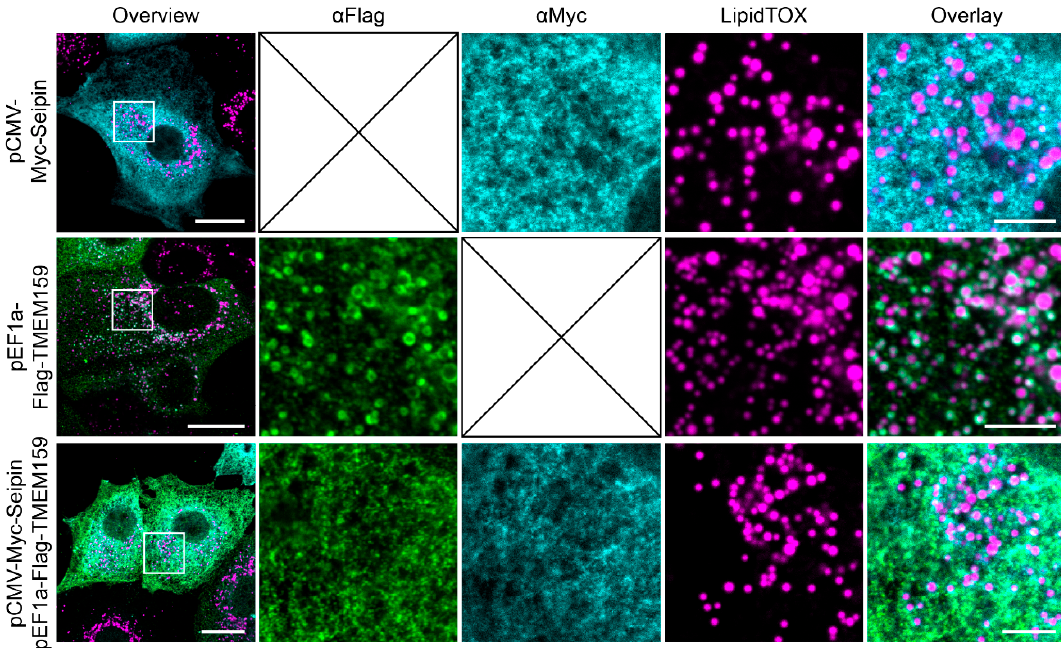
Figure 4. Seipin modulates promethin subcellular localization. MCF7 cells transfected with plasmids for expression of Flag-promethin and/or seipin-Myc were treated for 72 h with 200 µM oleic acid. Subsequently, LDs were stained with the neutral lipid dye LipidTOX and immunofluorescence microscopy was performed using antibodies against Flag and Myc. Seipin expression results in the loss of promethin from LDs and re-localization to the ER. Scale bar, overview 20 µm; zoomed overlay, 5 µm.